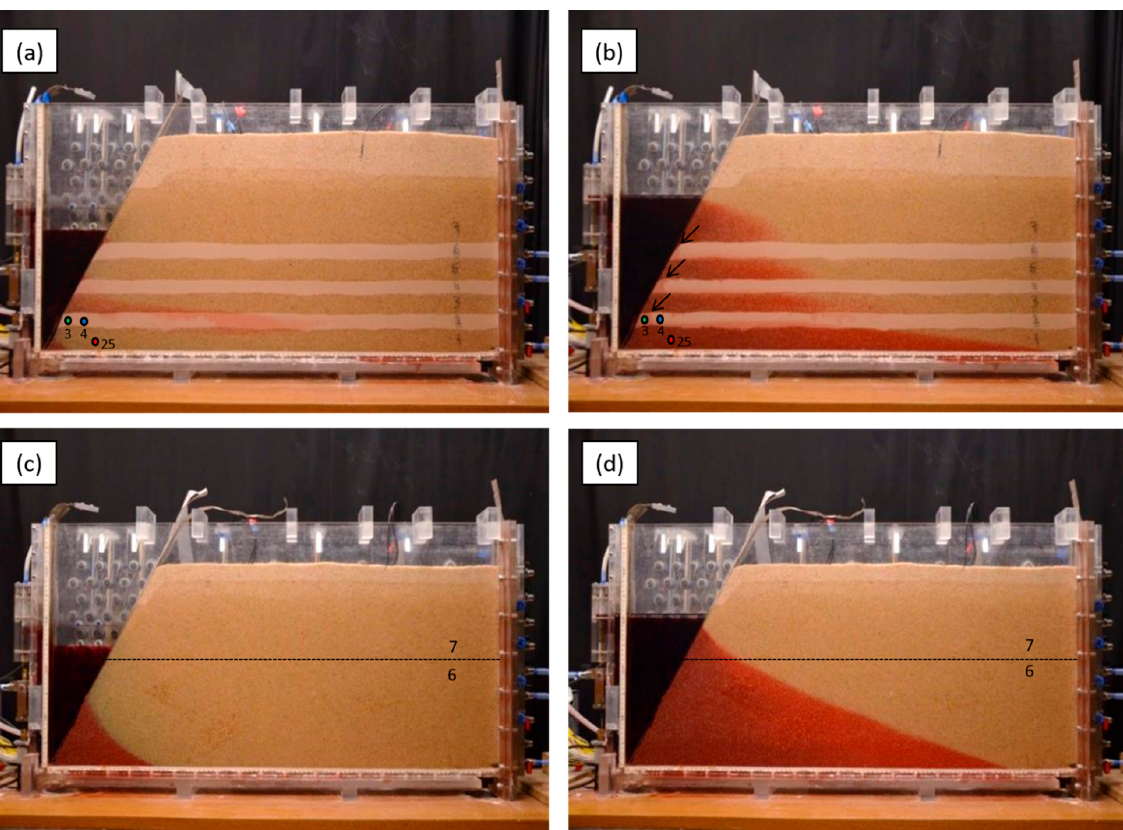
Figure 2. Saltwater is red and freshwater is colorless. Experiments E3-180 at low tide ( a ) and high tide ( b ), and E7-Hm-180 at low tide ( c ) and high tide ( d ). The arrows in ( b ) represent the maximum saltwater horizontal intrusion into the aquitards. The dashed line represents the height of layers 6–7 boundary as a reference.